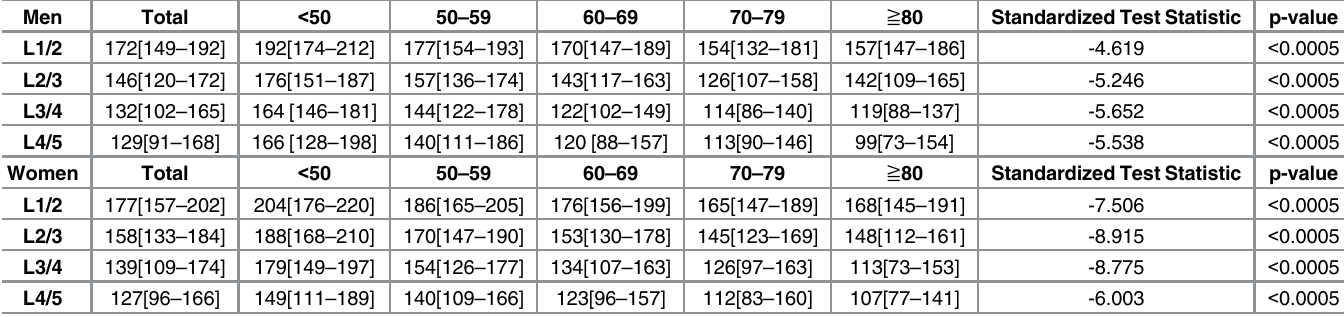
Table 2. Distribution of cross sectional area of dura (mm 2